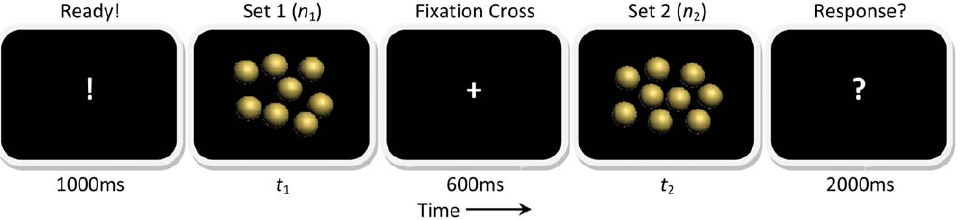
Figure 2. Procedure of a trial. The number of items in this figure is only for illustration, see Figure 1 for details of magnitudes used.